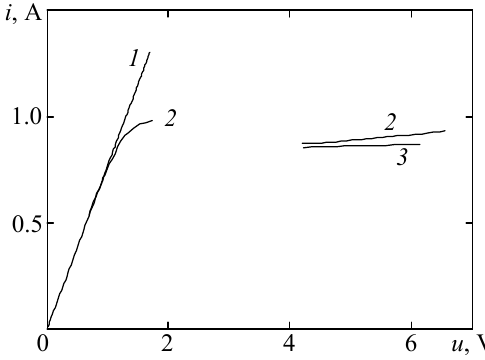
Fig. 1. I-V characteristic of the Gunn diode 3A702 at the test signal duration of 10 ns ( 1 ), 80 ns ( 2 ), and 1000 ns ( 3 ).